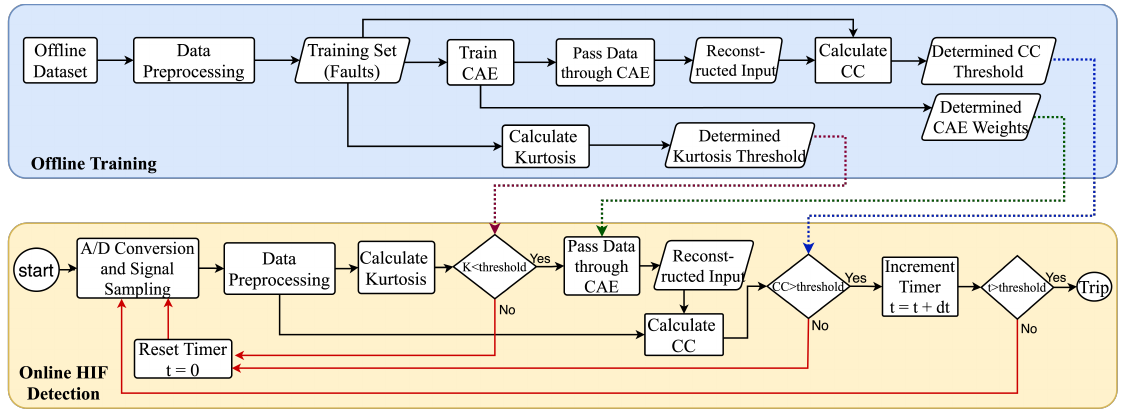
Figure 2. CAE Framework for HIF Detection